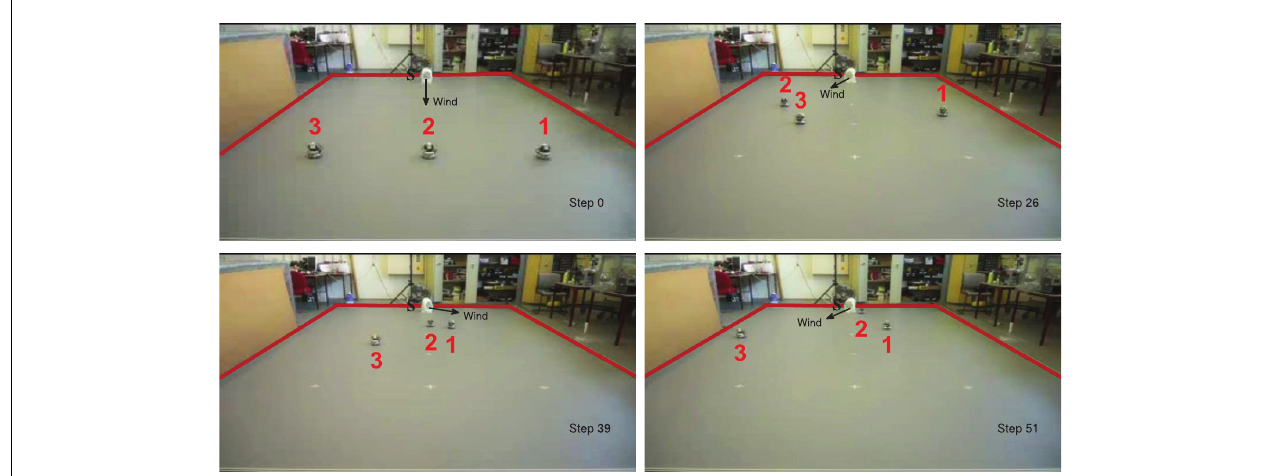
FIGURE 6 | Swarm searching with three robots . Snapshot of the collective search at particular steps. At each step, the source S is at location (10,24) and wind blows as indicated by the arrow. At step 0, the three robots start from locations (5,6), (10,6), and (15,6). At step 51, robot #2 found the source.